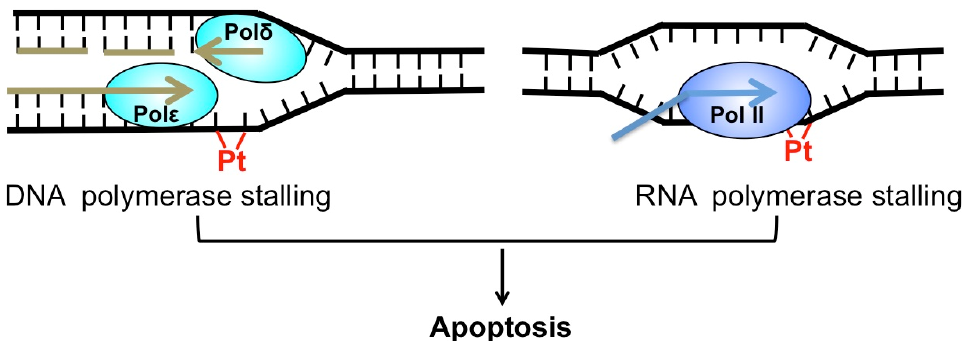
Figure 1. Cytotoxicity of cisplatin. Cisplatin-induced DNA adduct (red) blocks replicative DNA polymerase ( left ) and RNA polymerase ( right ). Both replication and transcription stalling can trigger apoptosis.